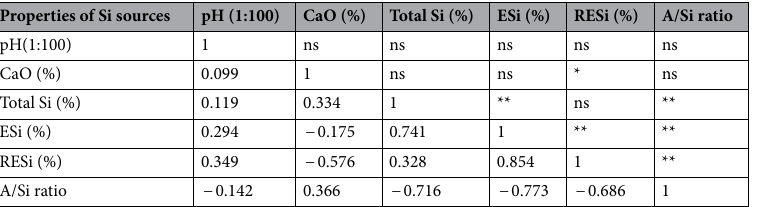
Table 2. Correlation between different chemical properties of slags [*significant at p < 0.05, **significant at p < 0.01 (each data represents an average of three replication)].